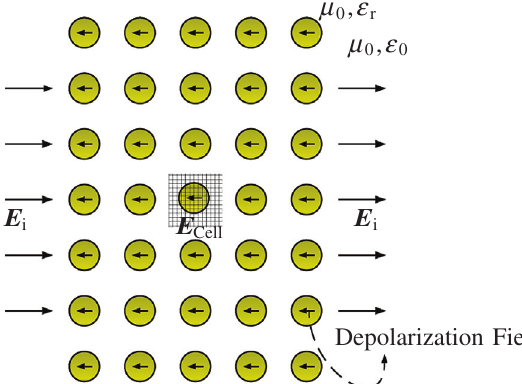
Figure 1. Periodic arrangement of dielectric scatterers of consti- tutive parameters ( l 0, e 0 ) embedded in a medium of background medium of permittivity ( l 0 , e r ). Arrows inside the scatterers indicate the depolarization field under the application of an incident field E i . The symbol E Cell represents the total field in a cubic